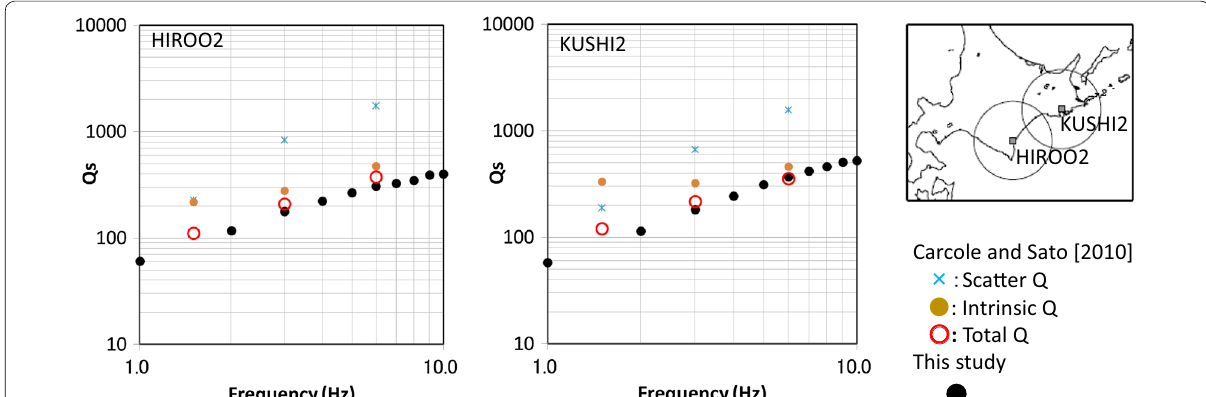
Fig. 3 Comparisons of Qs values obtained in this study and Carcolé and Sato (2010). The Qs values of this study (black circles) are computed as average values within 100 km in horizontal and 0–40 km in depth directions from stations of the KUSHI2 and the HIROO2. Total Qs (red open circles) of Carcolé and Sato (2010) is the sum of intrinsic Qs (blue crosses) and the scattering Qs (brown